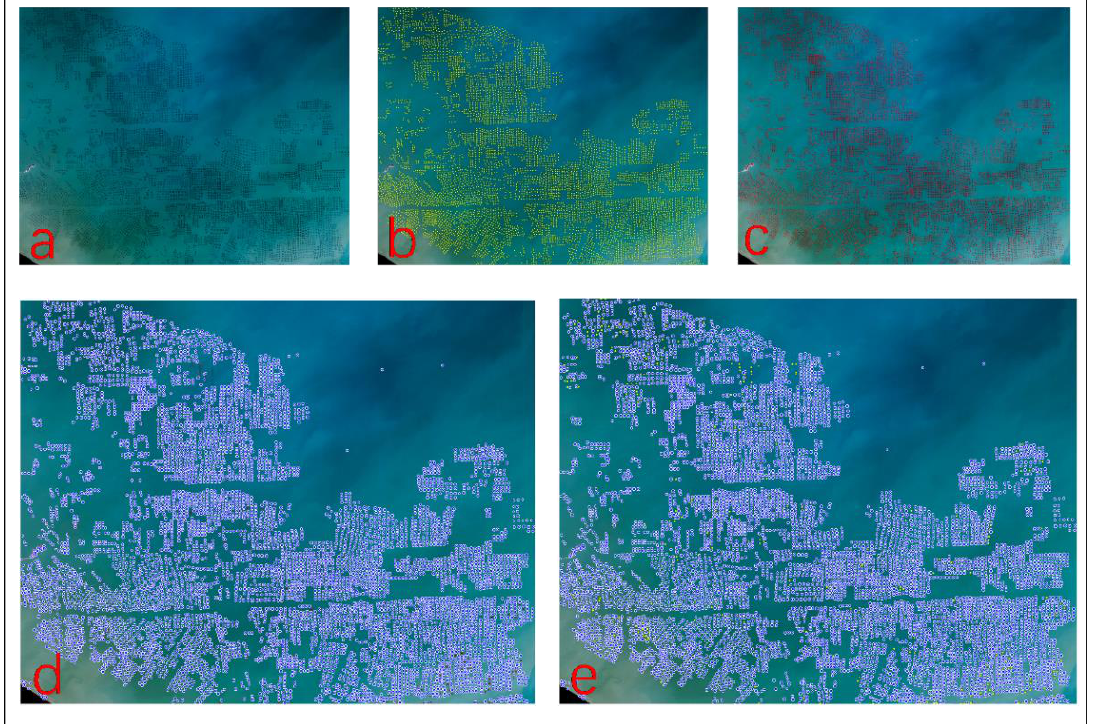
Figure 7. Experimental results in study area 1: ( a ) original image; ( b ) visual interpretation results; ( c ) identification results; ( d ) quantitative identification results; ( e ) overlap between the quantitative identification results and the visual interpretation results.